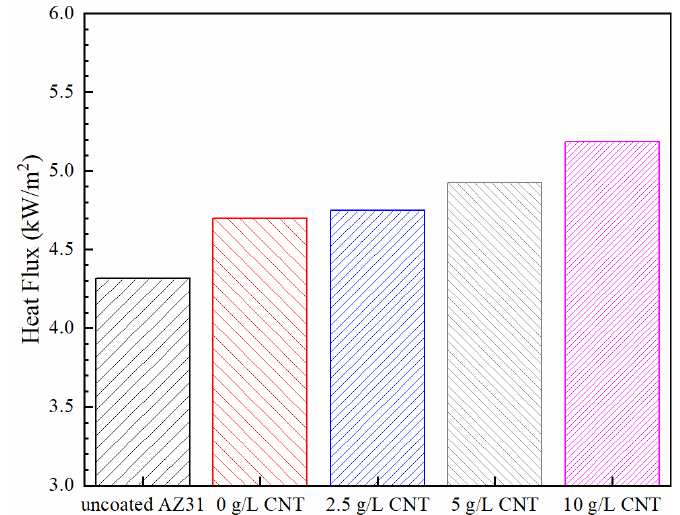
Figure 11. Heat flux of the AZ31 Mg substrate and the PEO coatings in different concentrations of CNT.